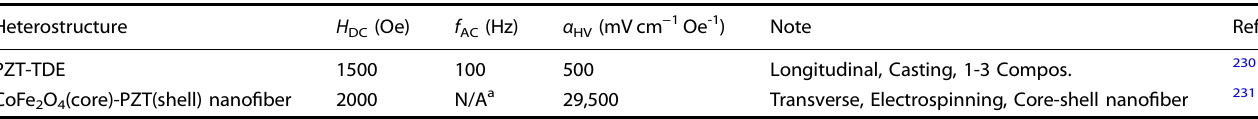
Table 4e. Room-temperature α HV in bulk and thin- fi lm vertical magnetoelectric composites Heterostructure Ref.